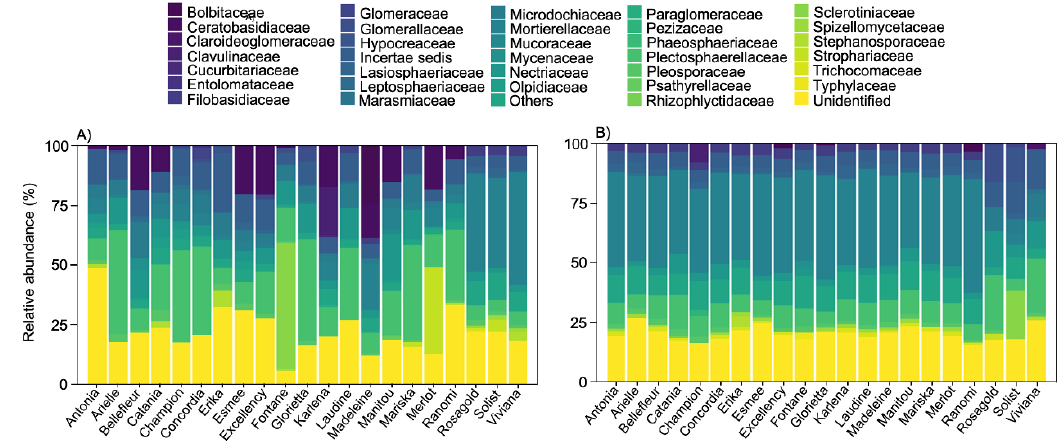
Figure 2. Taxonomic composition of root ( A ) and soil ( B ) fungal communities in different potato cultivars across all sampling times and replication blocks.